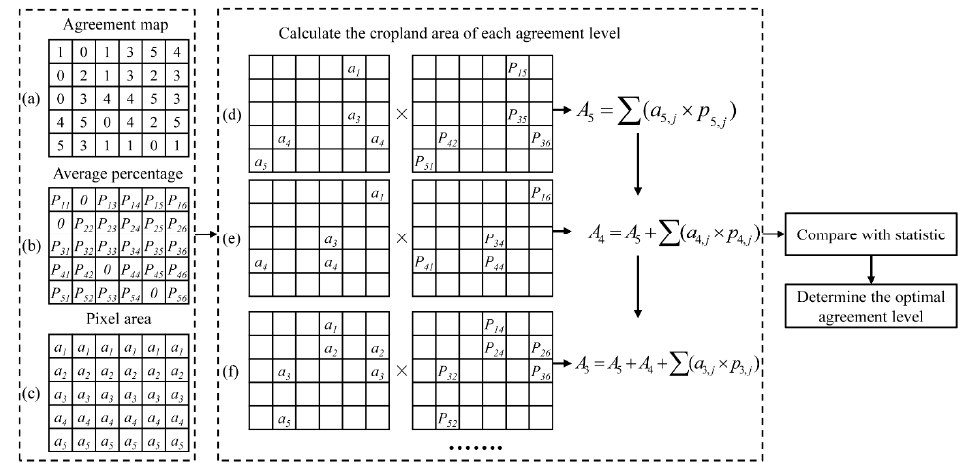
Figure 2. Flowchart on determination of the optimal agreement level. ( a ) Agreement map; ( b ) Average percentage; ( c ) Pixel area; ( d – f ) Calculations of cropland area with agreement level 5, 4, and 3